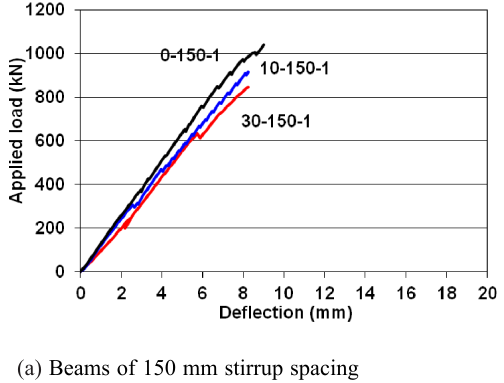
(a) Beams of 150 mm stirrup spacing (b) Beams of 100 mm stirrup Fig. 8. Load-deflection relationship for beams of a/d = 1